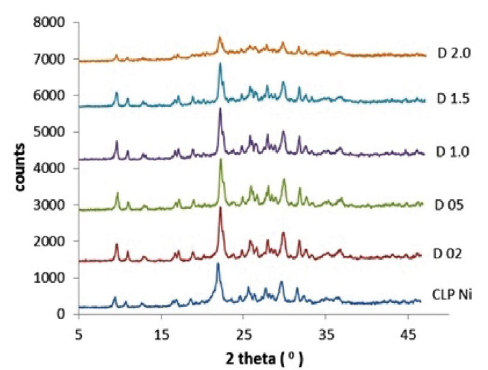
Fig. 2. XRD patterns of the raw and treated